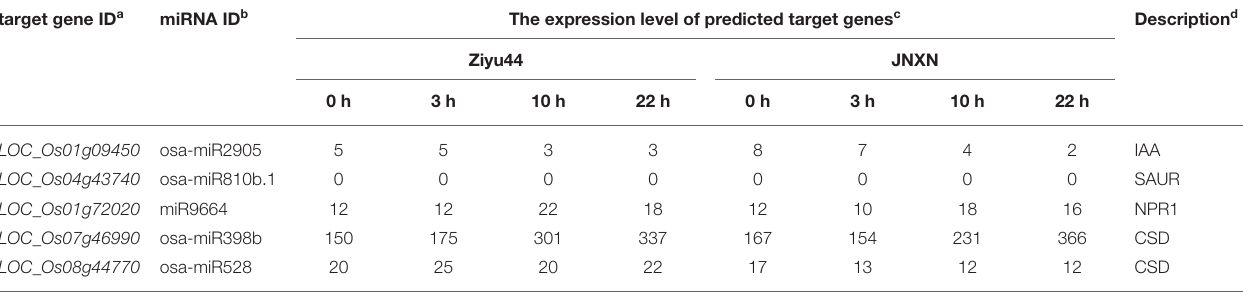
TABLE 2 | Expression pattern of 5 predicted target genes enriched in plant hormone signal transduction and peroxisome pathway. target gene ID a miRNA ID b The expression level of predicted target genes